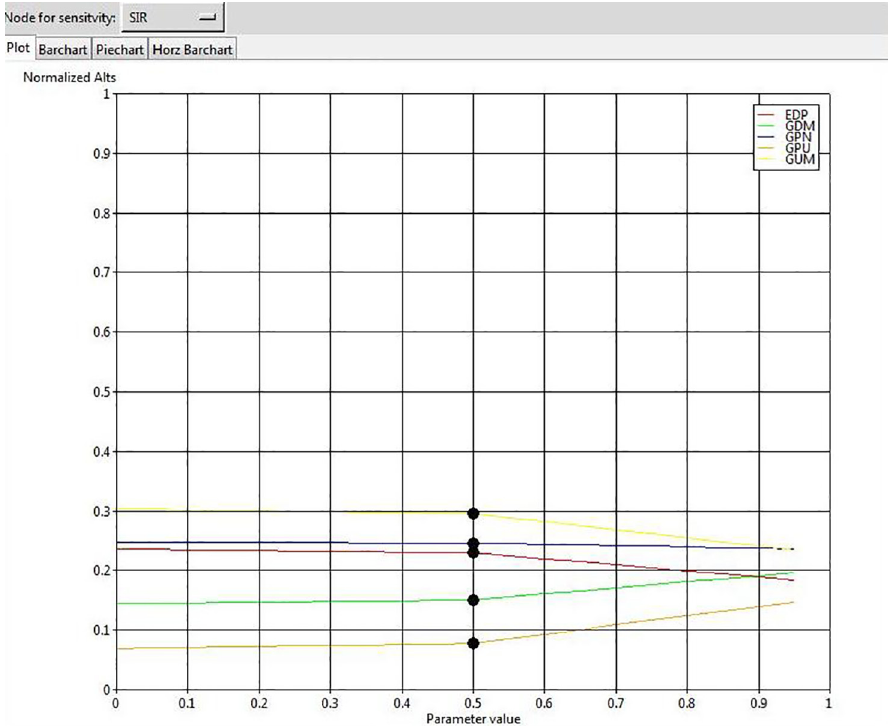
Fig 6. The results of sensitivity analysis for the node “ Stakeholder Integration ” .